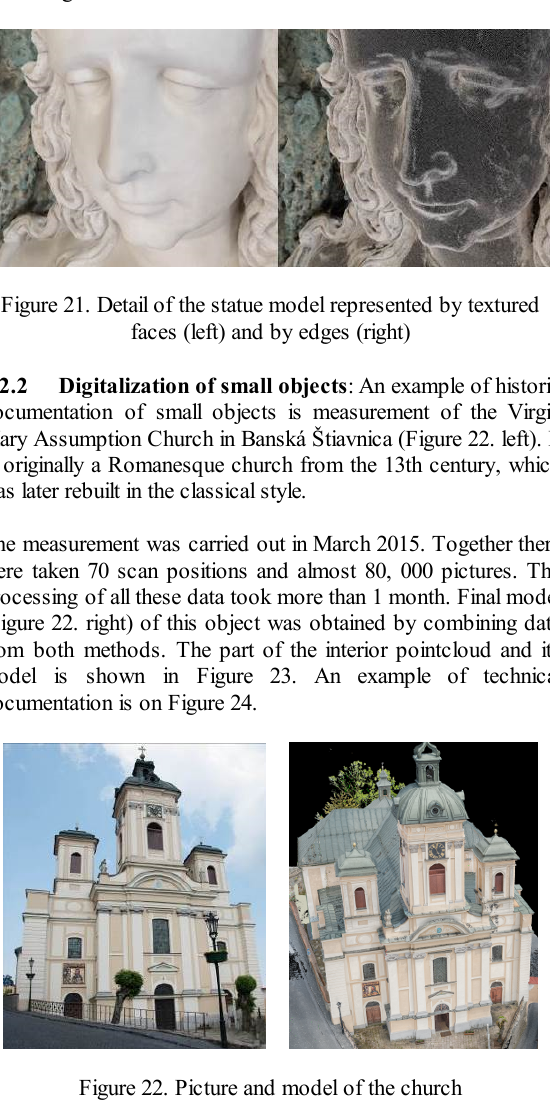
Figure 20. Final textured model of the Sala Terrena